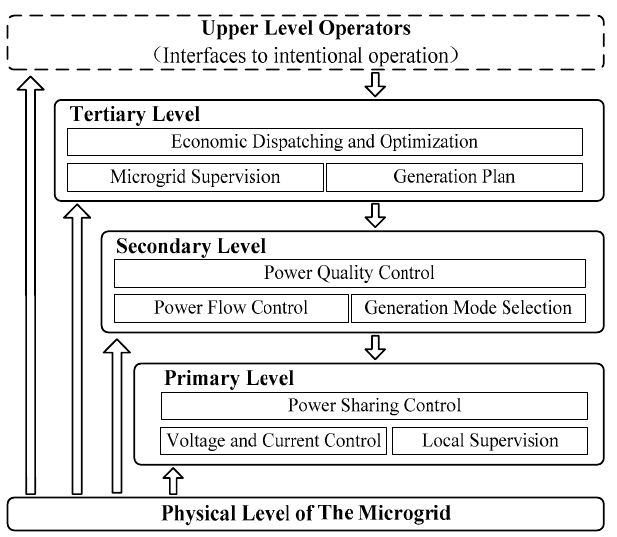
Figure 3. Hierarchical control framework.